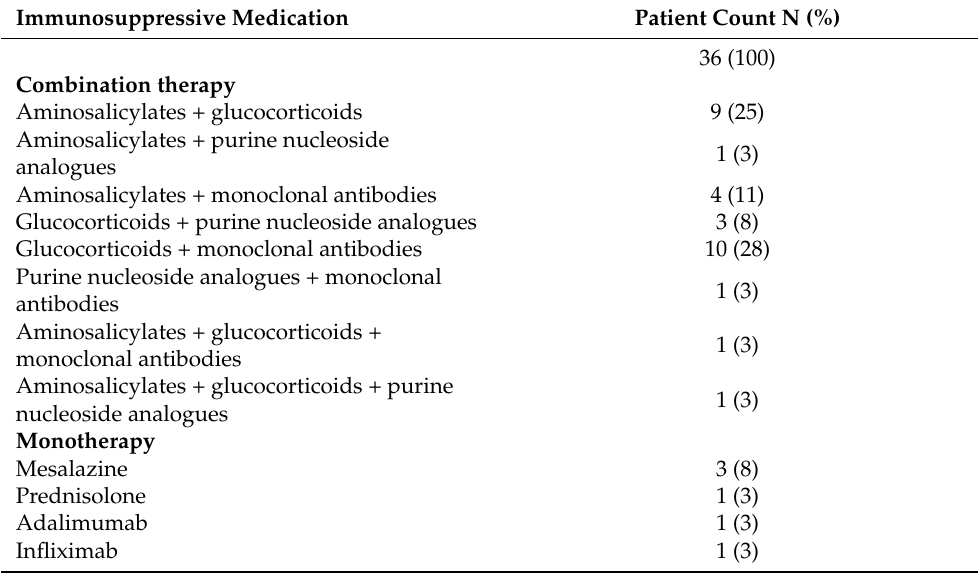
Table 3. Overview of the administered antiphlogistic and immunosuppressive